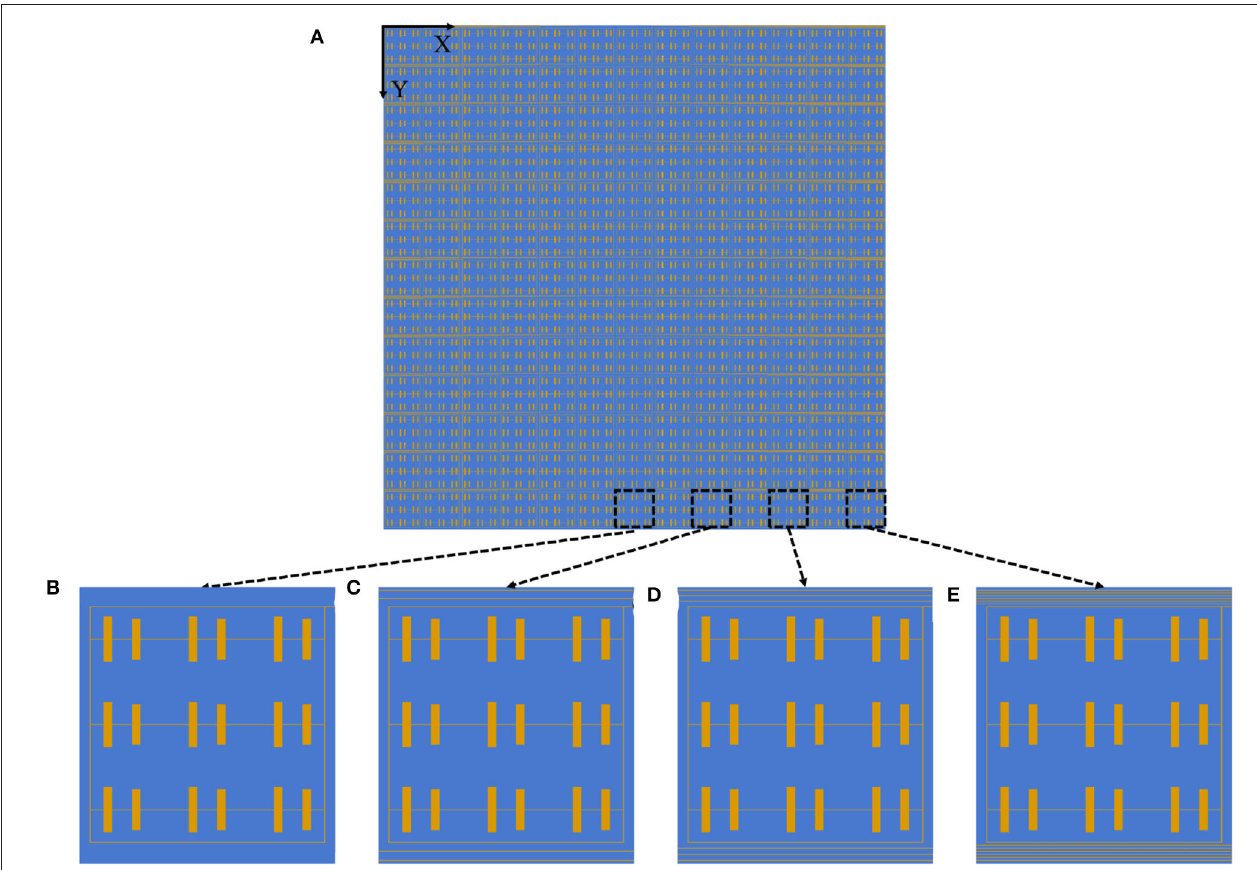
3 subarray. None trunk bias line (B) . Two trunk bias lines (C) . Three ×